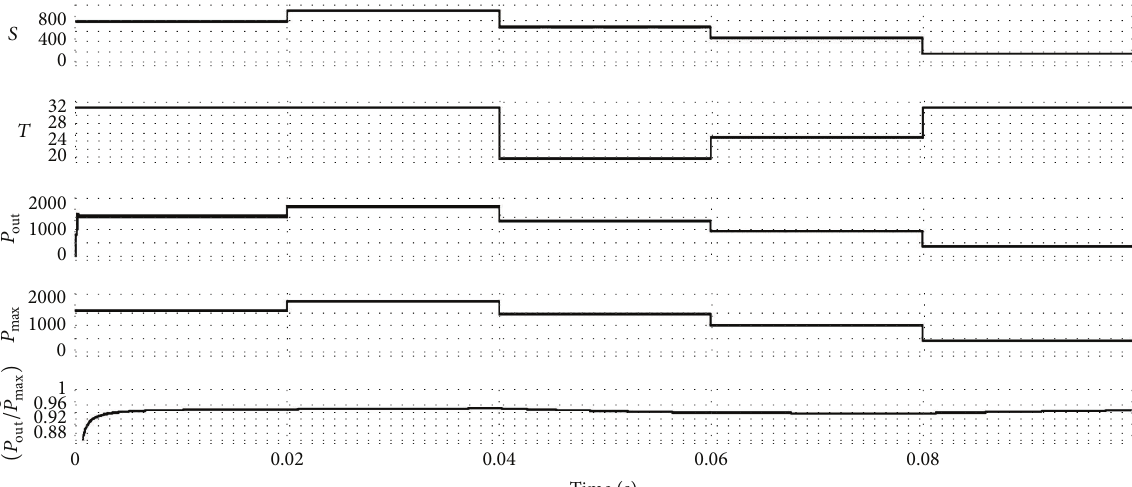
Figure 6: Irradiance profile ( 𝑆 ), temperature profile ( 𝑇 ), extracted power ( 𝑃 and average efficiency obtained with CV technique.